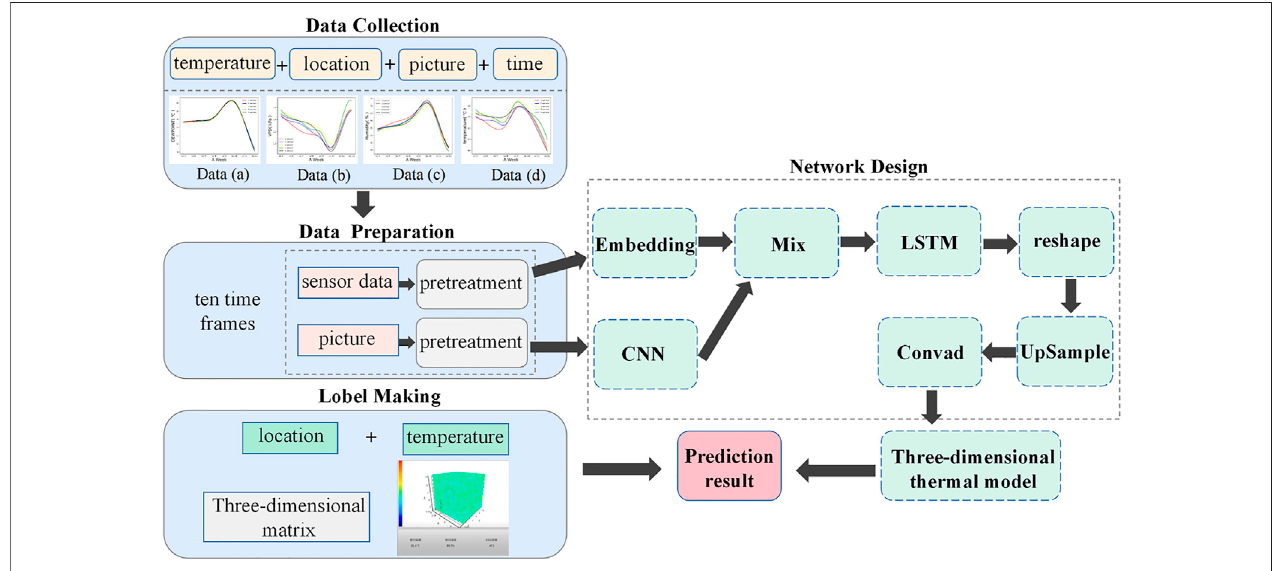
FIGURE 4 | Training process design.